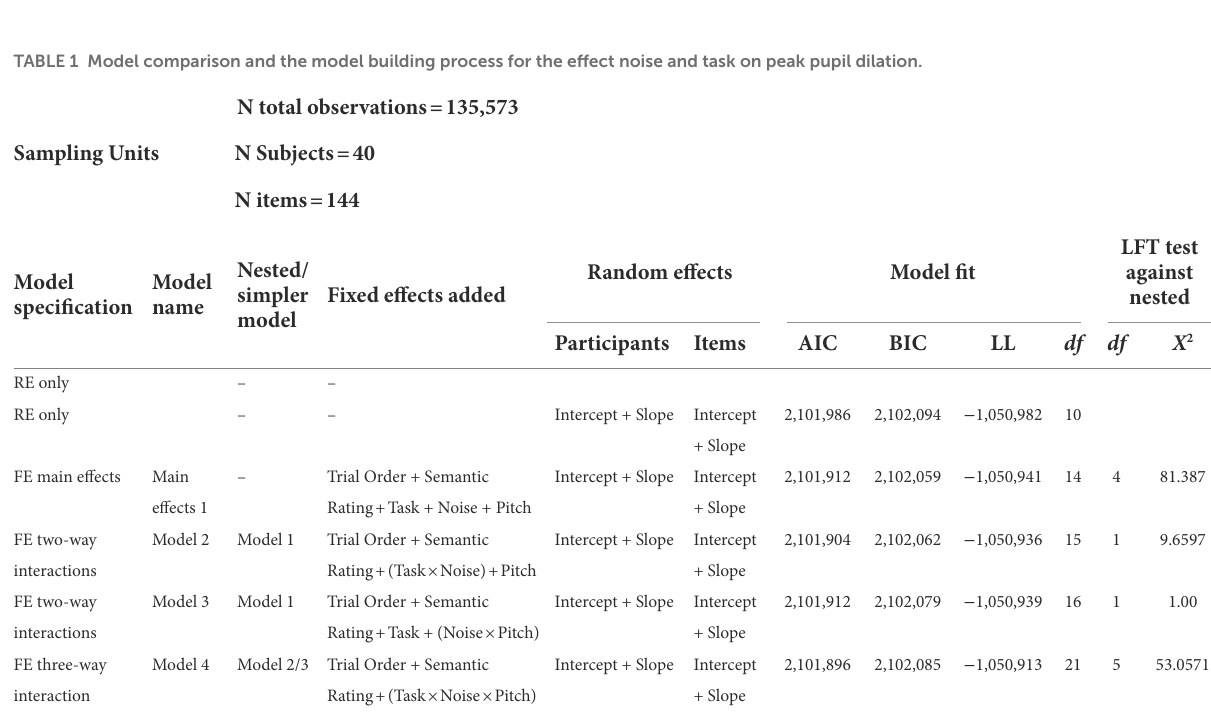
TABLE 1 Model comparison and the model building process for the effect noise and task on peak pupil dilation.